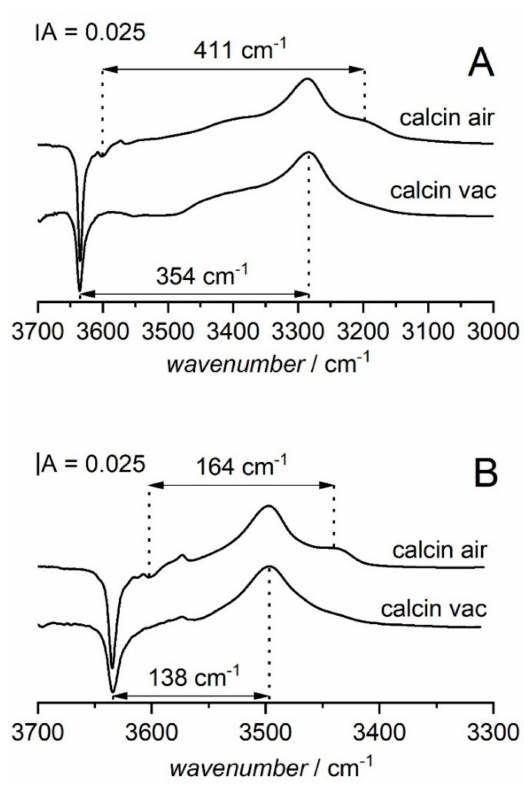
Figure 7. ( A ) The di ff erence spectra of OH groups in zeolite calcined in air and in vacuum interacting with CO. ( B ) The di ff erence spectra of OH groups in zeolite calcined in atmospheric air and in vacuum interacting with N 2 . All the spectra were recorded at 170 K. Figure adapted with the permission from